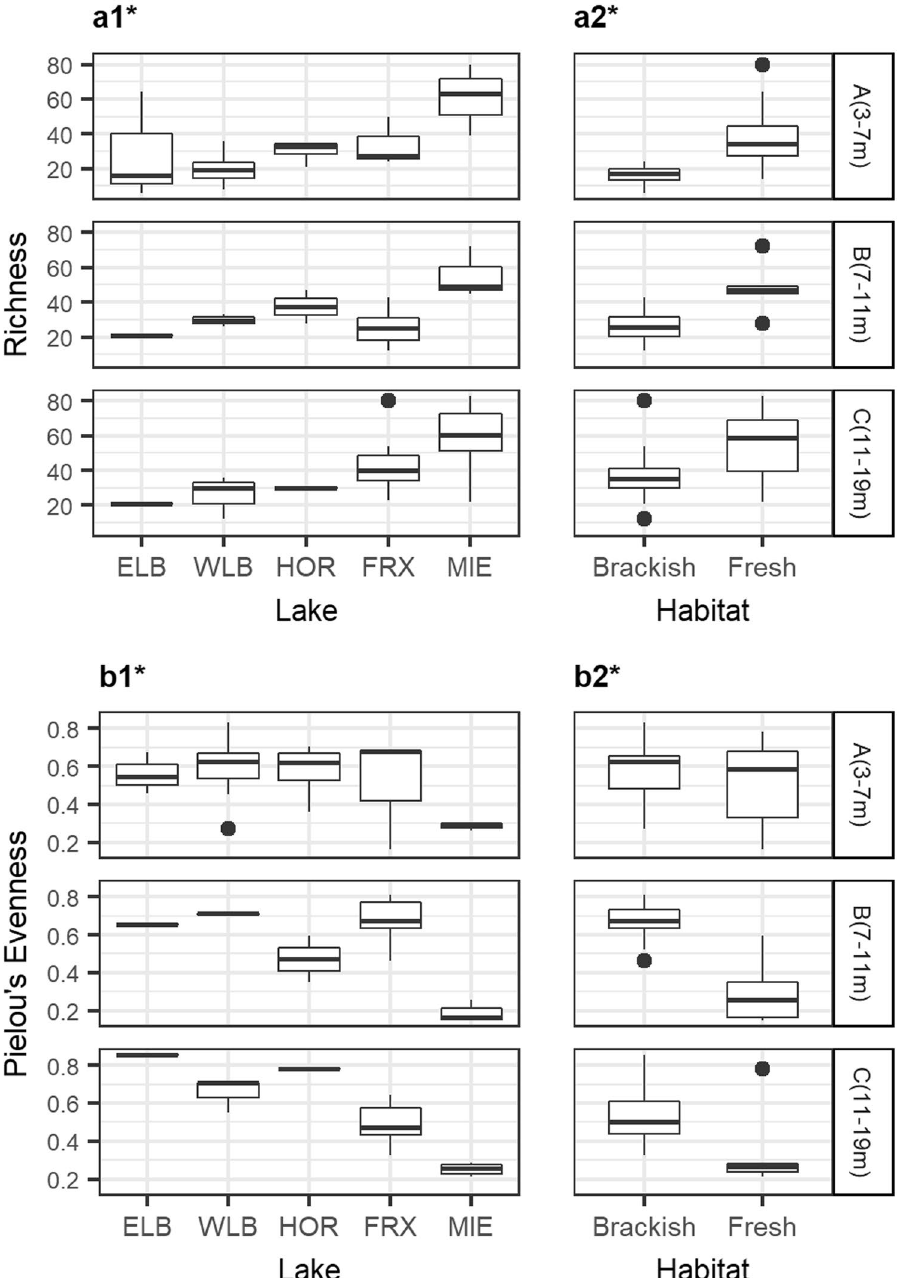
Figure 5. Distribution of the alpha diversity estimators according to depth layer. This includes richness per lake ( a1 ), richness per habitat ( a2 ), Pielou’s evenness per lake ( b1 ) and Pielou’s evenness per habitat ( b2 ). Asterisks indicate significant differences (Kuskal-Wallis Test, p < 0.05). ELB: Lake Bonney East lobe (n = 5), WLB: Lake Bonney West lobe (n = 19), FRX: Lake Fryxell (n = 27), HOR: Lake Hoare (n = 7), MIE: Lake Miers (n =